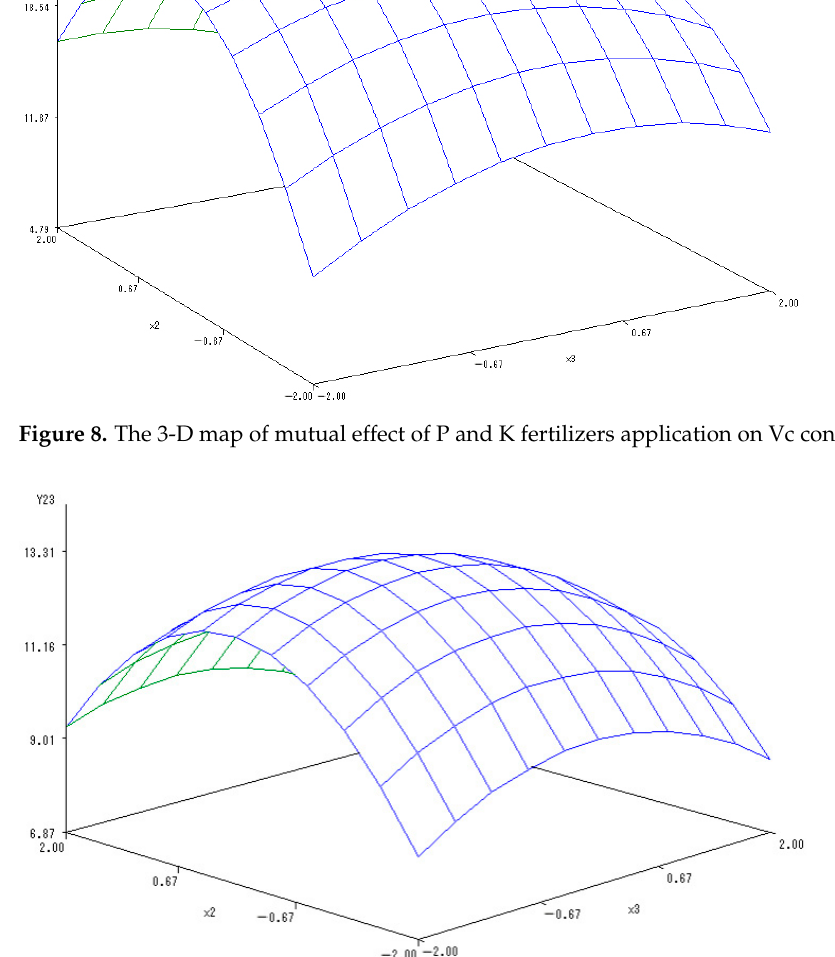
Figure 8. The 3 ‐ D map of mutual effect of P and K fertilizers application on Vc content in melon.